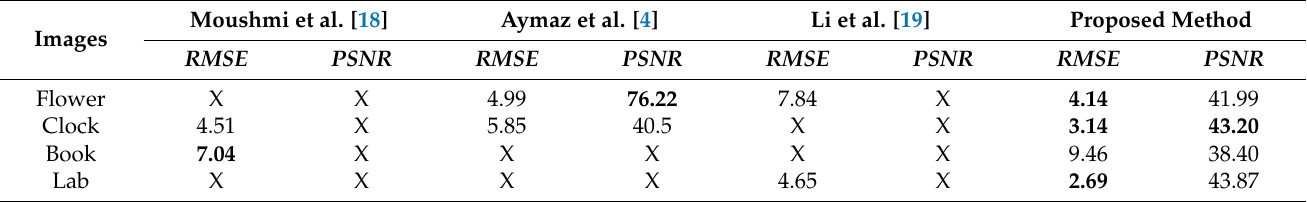
Table 2. The methodologies from the literature have been compared to a number of